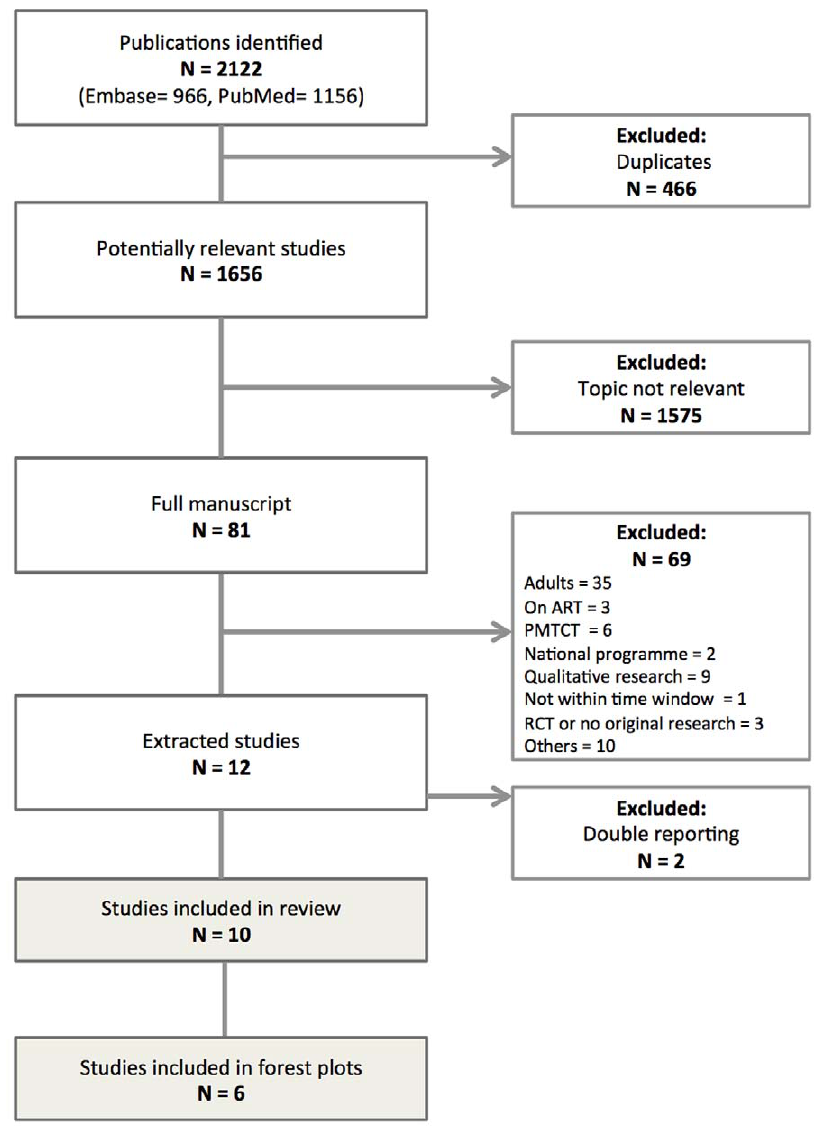
Figure 1. Identification and selection of studies. ART: Antiretroviral therapy; RCT: Randomized controlled trial; PMTCT: Prevention of mother to child transmission.